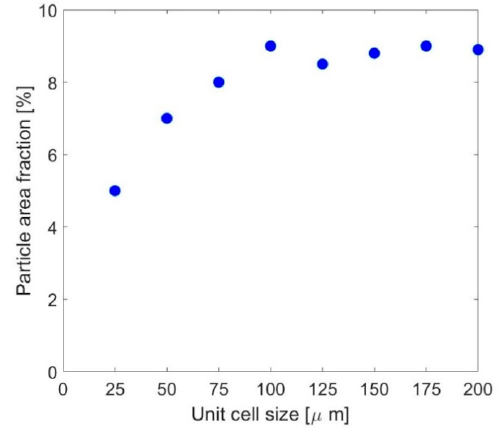
The value of particle area fraction as a function of unit cell size is shown in Figure A3: